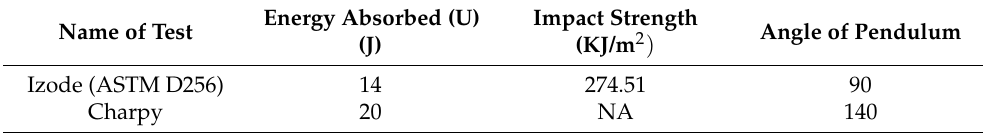
Table 11. Impact test results for Charpy and Izod conditions for Deccani sheep horn.